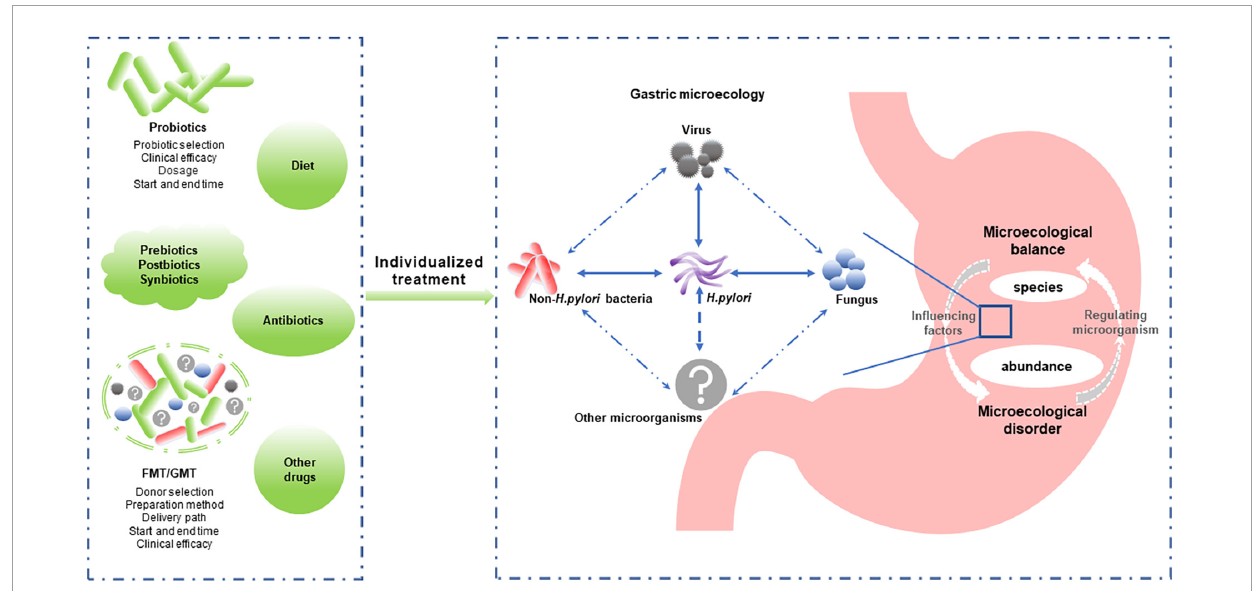
FIGURE2 Individualized reconstruction of the healthy gastric microbiota is a promising strategy for managing microecology dysbiosis-associated gastric diseases. Gastric microbiota composition and abundance and the interaction between gastric microbiomes (including Helicobacter pylori and non- H. pylori bacteria, fungi, and viruses) play important roles in gastric microecological homeostasis. Modulating the microbiota (probiotics, prebiotics, postbiotics, synbiotics, and FMT/GMT) is expected to improve and restore the gastric microflora balance. However, individualized treatment options, such as the bacteria type or donor selection, delivery path, and start and end times, require further study. FMT, fecal microbiota transplantation; GMT, gastric microbiota